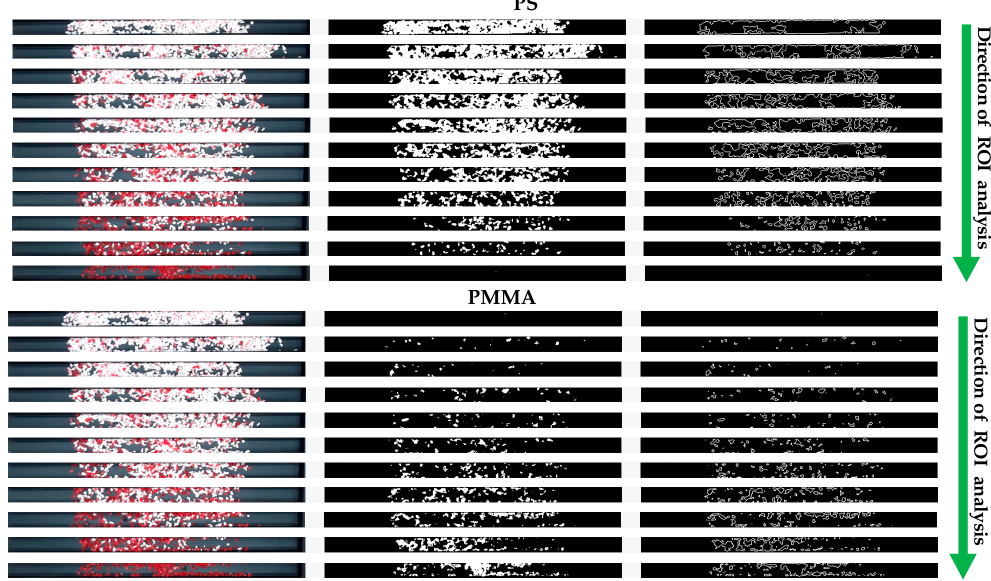
Figure 8. Sequence of evaluation of the sample ROIs and materials.